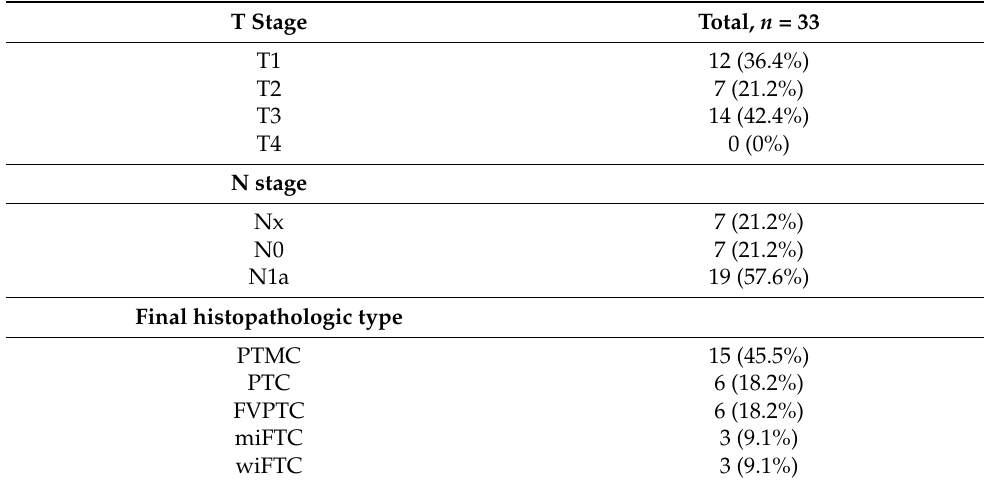
Table 2. Histopathologic results of initial BABA robotic thyroid